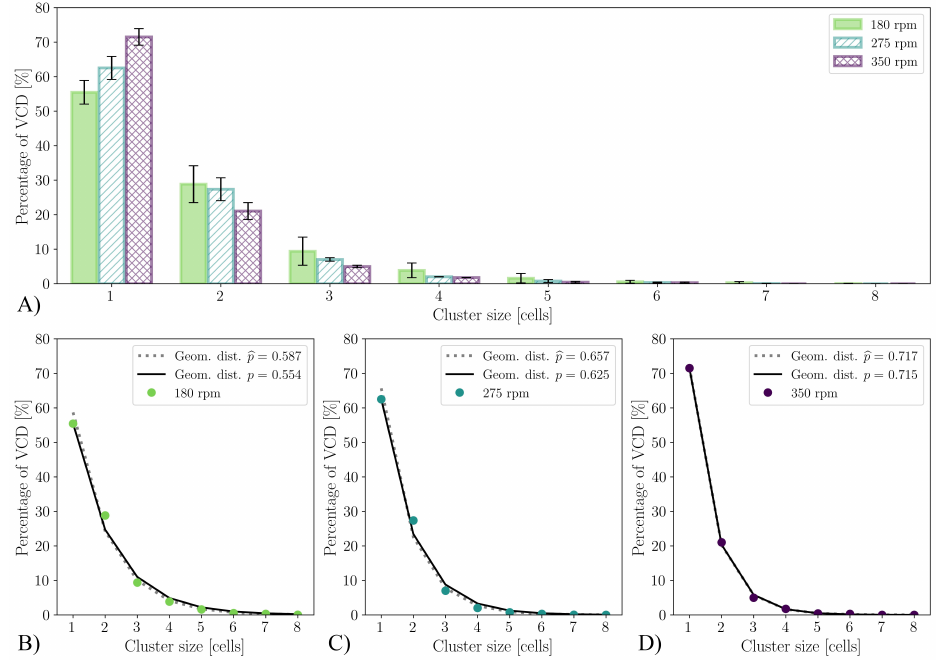
Figure 13. Cluster size distribution at t VCD . ( A ) comparison of the cluster size distribution at the max three investigated stirrer speeds. ( B – D ) show the size distribution measured and approximated by the geometric distribution. The geometric distribution where parameter p is equal to the proportion of non-aggregated viable cells is shown as a solid line. The dashed line, in contrast, shows the geometric distribution with parameter p that is determined by the maximum likelihood estimation ˆ p